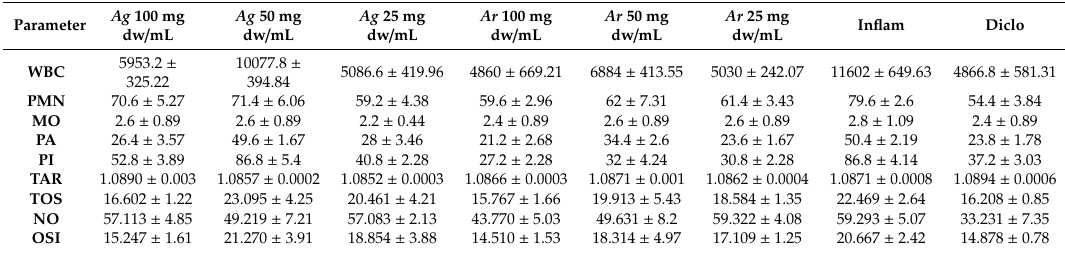
Table 8. Anti-inflammatory activity of A. genevensis ( Ag1 ) and A. reptans ( Ar1 ) extracts (WBC, PMN, MO, PA, PI, TAR, TOS, NO, OSI).